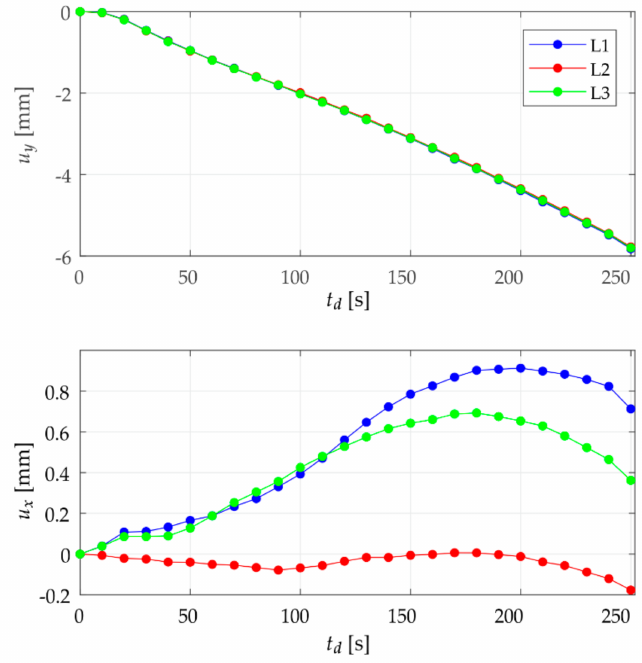
Figure 4. Relative displacements between the plates in joint